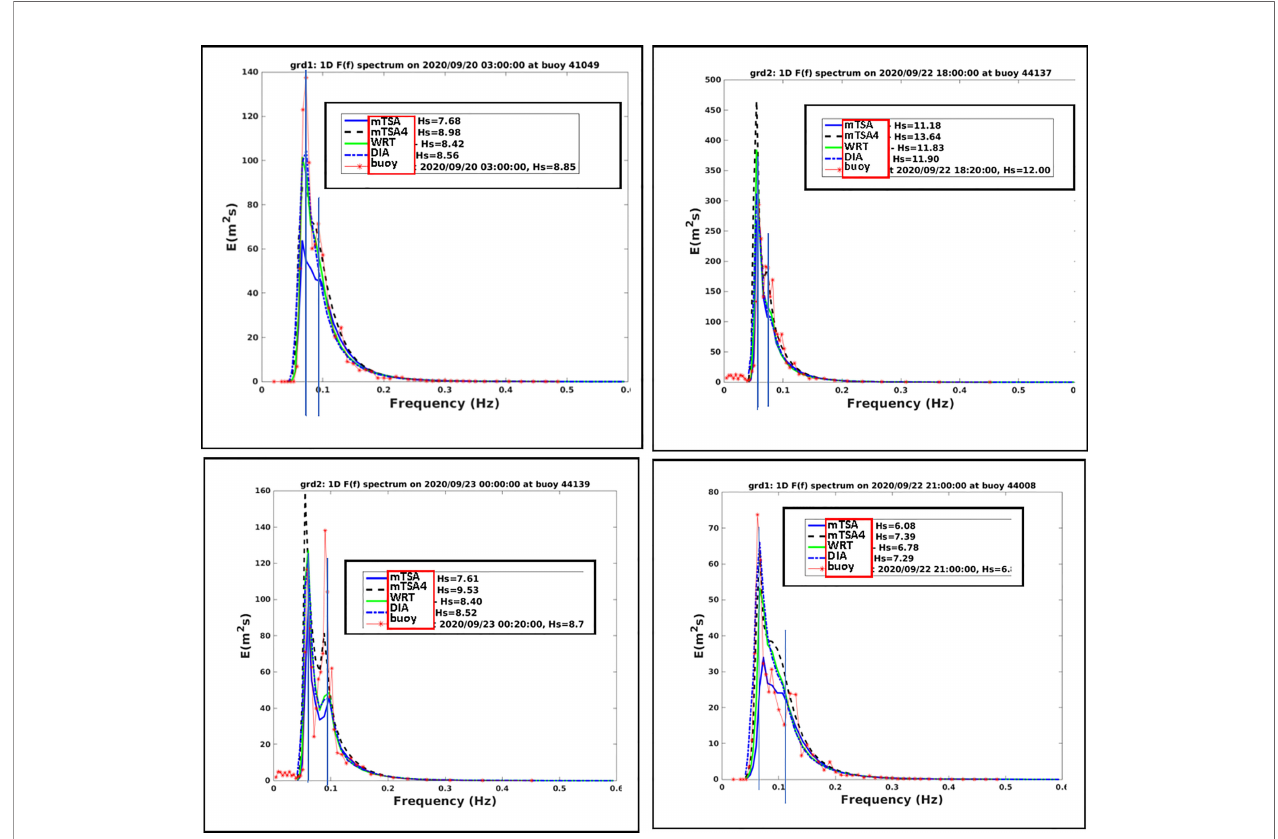
FIGURE 8 | Hurricane Teddy at about the peak of the storm, showing 1D spectrum observed at buoys 41049, 44008, 44137, 44139 compared to simulated results from WW3 with ST4 source terms, DIA, WRT, and mTSA, where mTSA4 assumes the ST4 tuning used in Perrie et al.